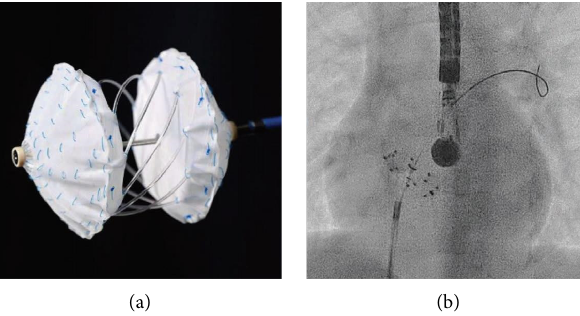
Figure 1: Schematic representation of the CBSO occluder (a). Te device has two opposing polyester covers that are attached to a PLGA monoflament framework. At each end of the flaments (a total of 8), there is a flament holder made of polyetheretherketone. At the distal tip of the implant, a nut made of Phynox keeps the flaments in place and ensures visibility under X-ray